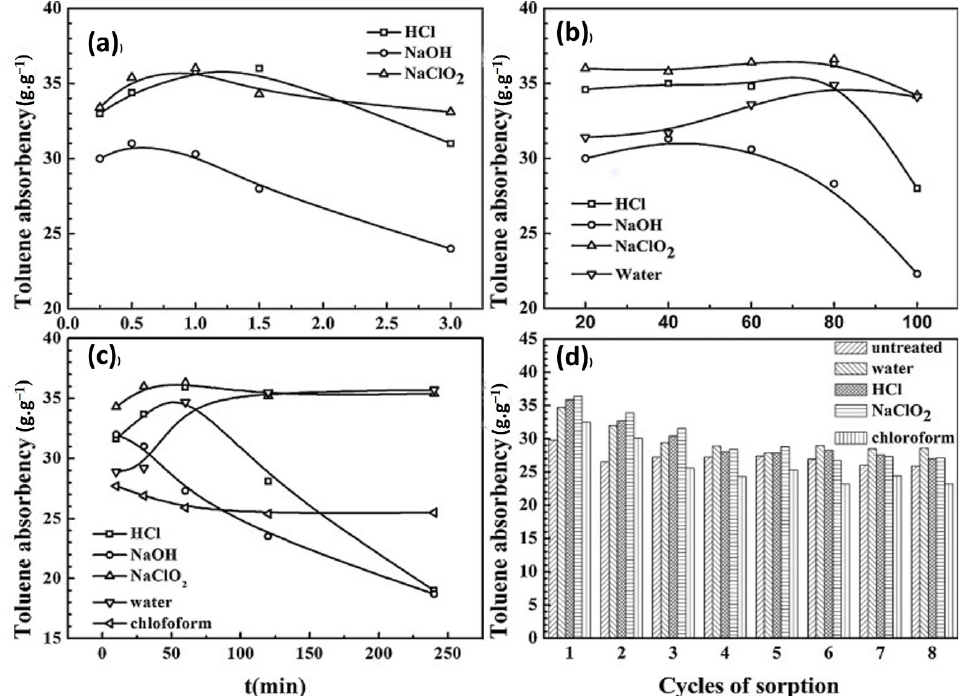
Figure 22. ( a ) The impact of treatment intensity on the absorbance of oil (T° = 20 °C; t = 1 h). ( b ) The impact of treatment temperature on oil absorption is as follows: NaOH, NaClO 2 , and HCl solution concentrations are 0.25%, 1%, and 1%, correspondingly; duration is 1 h. ( c ) The impact of the proce- dure period on oil absorption properties is as follows: the concentrations of NaOH, NaClO 2 , and HCl solutions are 0.25%, 1%, and 1%, correspondingly. The temperature is 80 °C. ( d ) Crude and processed kapok fiber durability. Reprinted with permission from Ref. [8]. Copyright 2012, copy- right Elsevier.